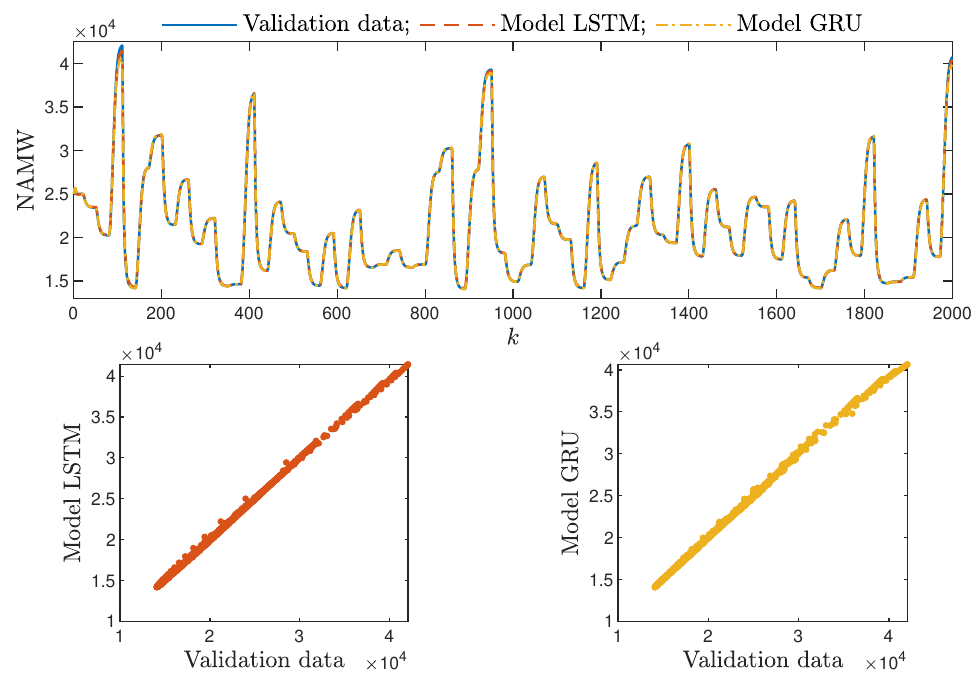
Figure 11. The polymerisation reactor: the validation dataset vs. the output of the LSTM and GRU models for n N = 10, n A = n B = 1.